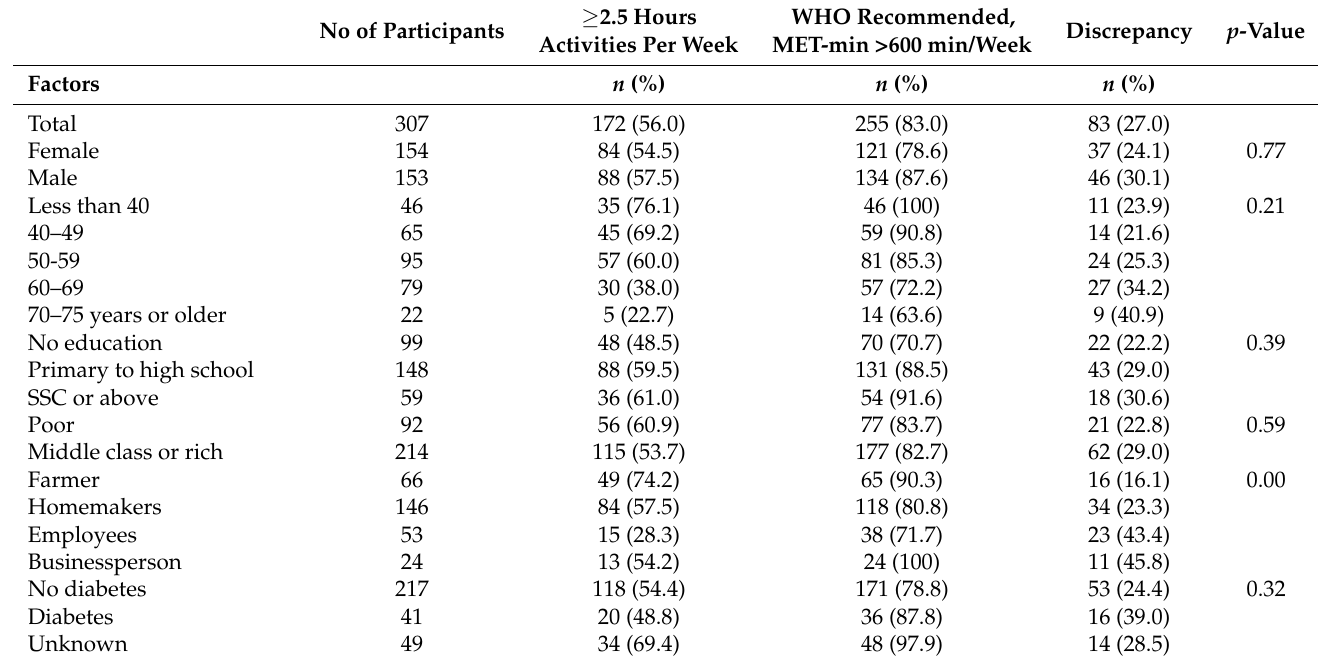
Table 1. Difference between WHO recommended MET-min ≥ 600 per week and self-reported physically active more than 2.5 h per week and associated sociodemographic factors among the people with high blood pressure. ≥ 2.5 Hours WHO Recommended, No of Participants Activities Per Week